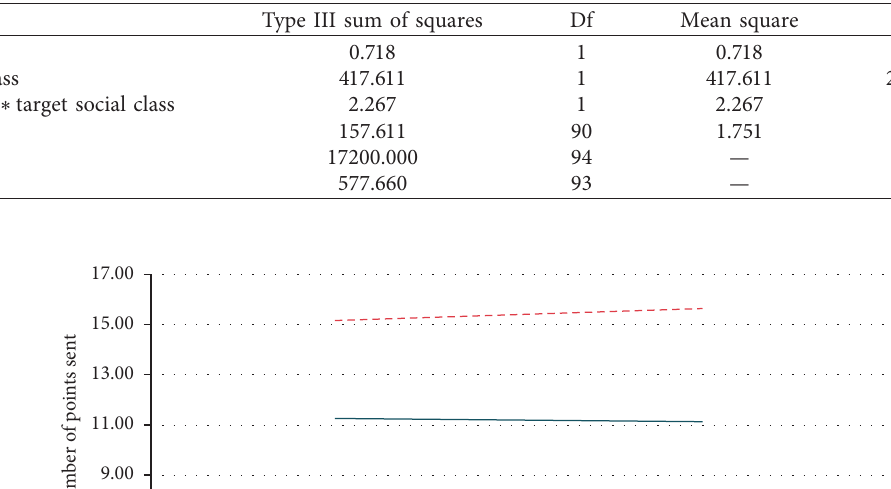
Table 5: The ANOVA results of two-factor between-subjects experiment design.